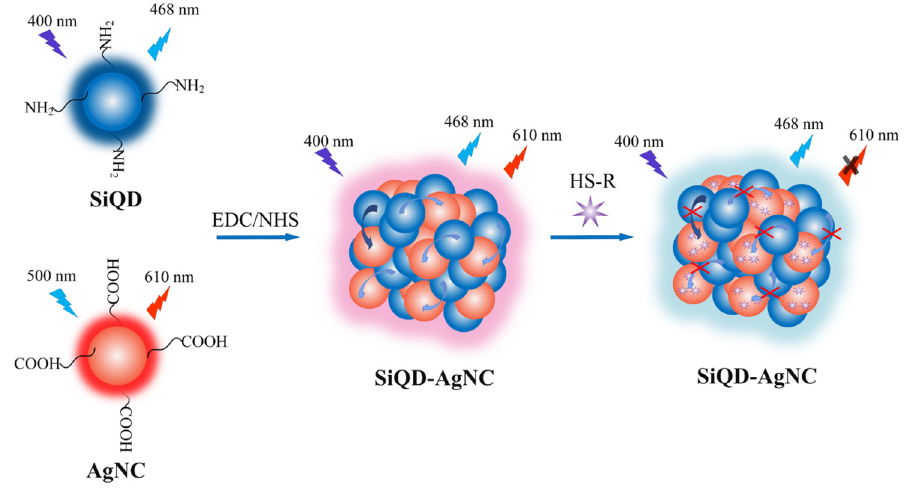
Figure 3. The detection principle of the SiQDs-AgNCs complex to hydrogen sul fi de and mercap-